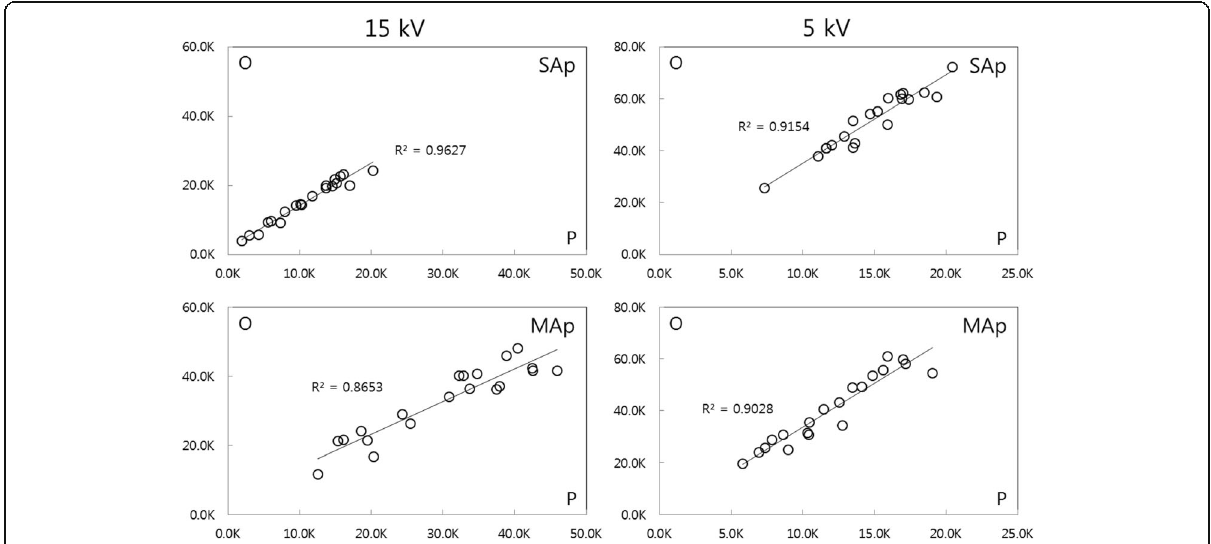
Fig. 5 Correlation of the O and P intensities for the reference materials obtained at 15 kV and 5 kV using the FE-SEM. Distributions of data points indicate much higher reliability of the FE-SEM with high R 2 values, compared to those of the